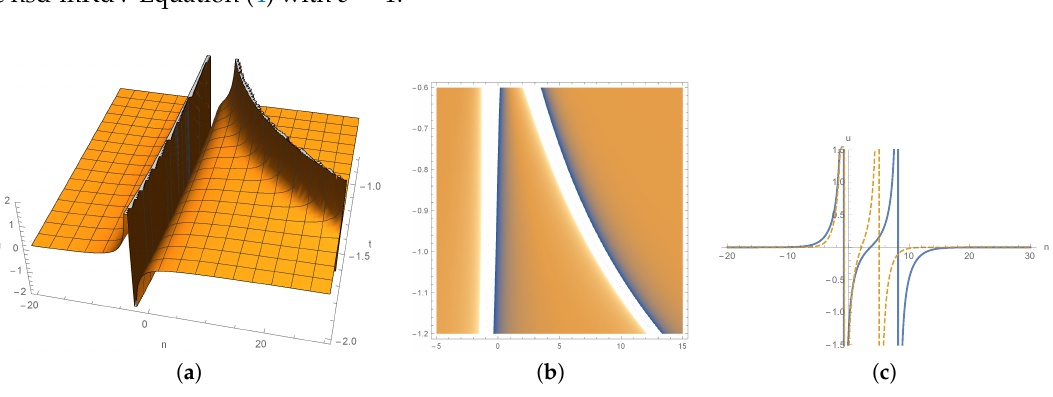
Figure 7. u n given by (38) with (cid:101) = 1 for c 1 = 1, c 2 = 0.8 and α 1 = α 2 = 1. ( a ) shape and motion; ( b ) a contour plot of ( a ) with range n ∈ [ − 5,15 ] and t ∈ [ − 1.2, − 0.6 ] ; ( c ) waves in blue (solid line) and yellow (dotted line) stand for plot ( a ) at t = − 1 and t = − 0.8, respectively.